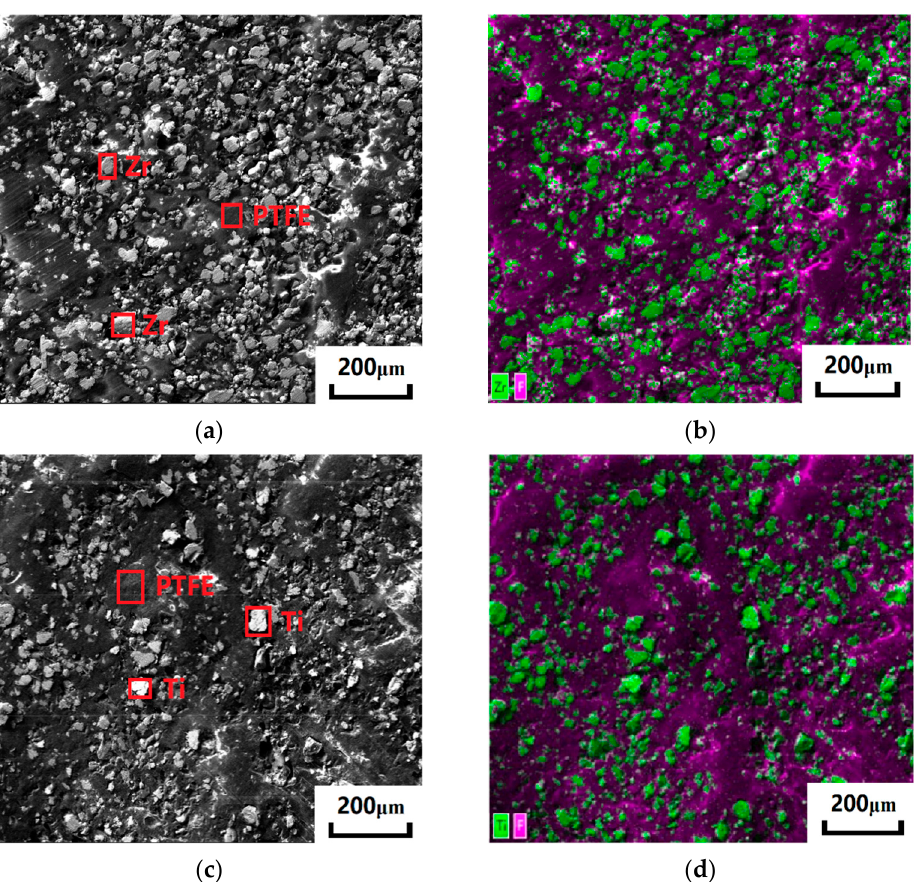
Figure 2. Microstructure of the Zr/PTFE, Ti/PTFE section. ( a ) SEM of Zr/PTFE, ( b ) EDS of Zr/PTFE, ( c ) SEM of Ti/PTFE, ( d ) EDS of Ti/PTFE.